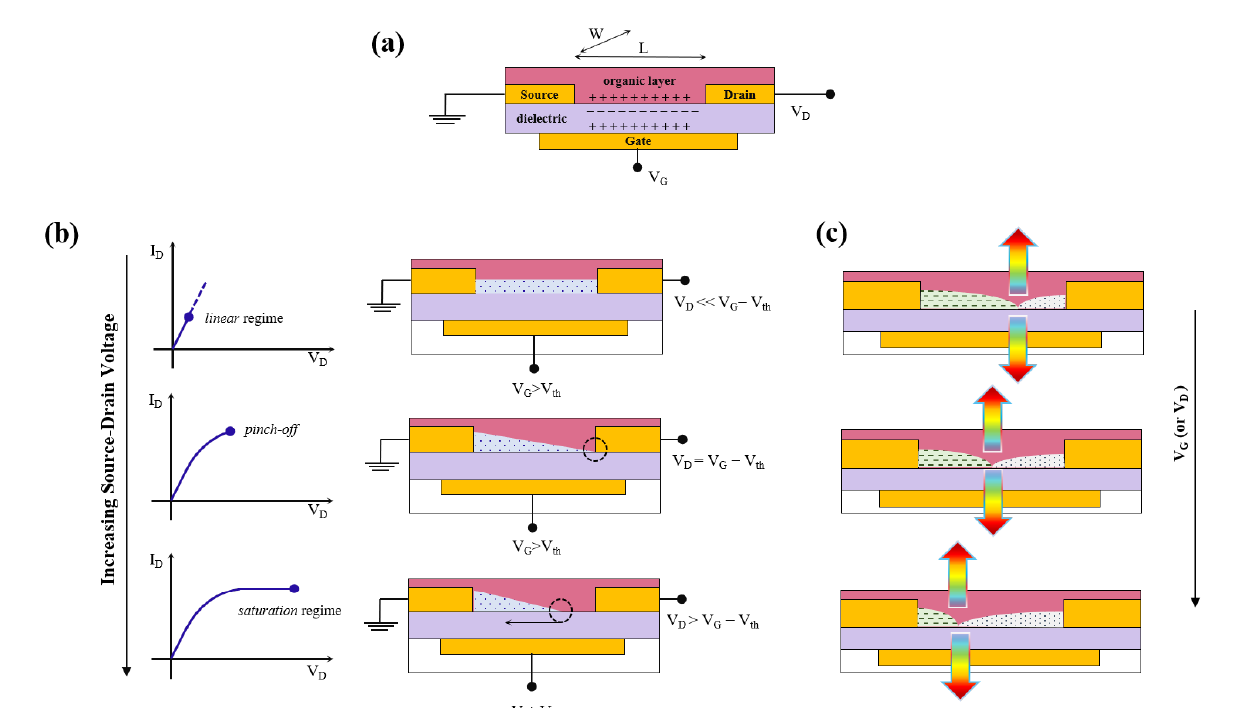
Figure 2. Organic light emitting transistor transport mechanism and light emission. ( a ) Schematic drawing representing the transistor structure and features ( V D : drain-source voltage, V G : gate voltage, V th : threshold voltage, W : channel width, L : channel length). ( b ) Charge transport regimes and corresponding transistor current-voltage curves (top to bottom: linear regime, pinch-off and saturation regime). ( c ) Electrons and holes distributions can be spatially controlled through appropriate bias within the channel.